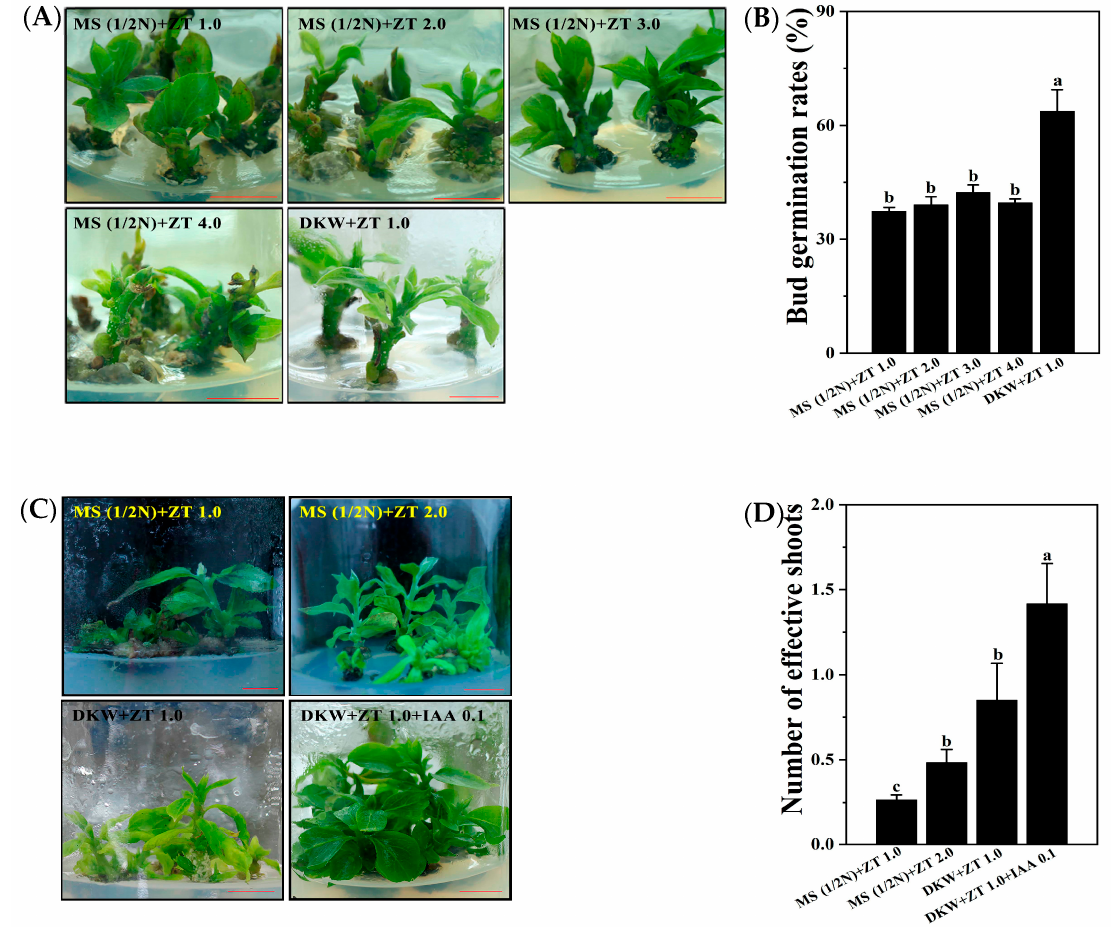
Figure 1. Establishment of the primary culture and subculture of ‘Gongcheng Shuishi’ persimmon. ( A ) Primary culture of ‘Gongcheng Shuishi’ in different media for 2 months. ( B ) The bud germination rates of ‘Gongcheng Shuishi’ in different media for 2 months. ( C ) The subculture of ‘Gongcheng Shuishi’ in different media for 1 month. ( D ) The number of effective shoots of ‘Gongcheng Shuishi’ in different media for 1 month. Bar = 1.0 cm. The unit of hormone concentration is mg/L, followed by the number in ( A , C ). Means followed by different letters indicate significant differences at p ≤ 0.05 by Tukey’s